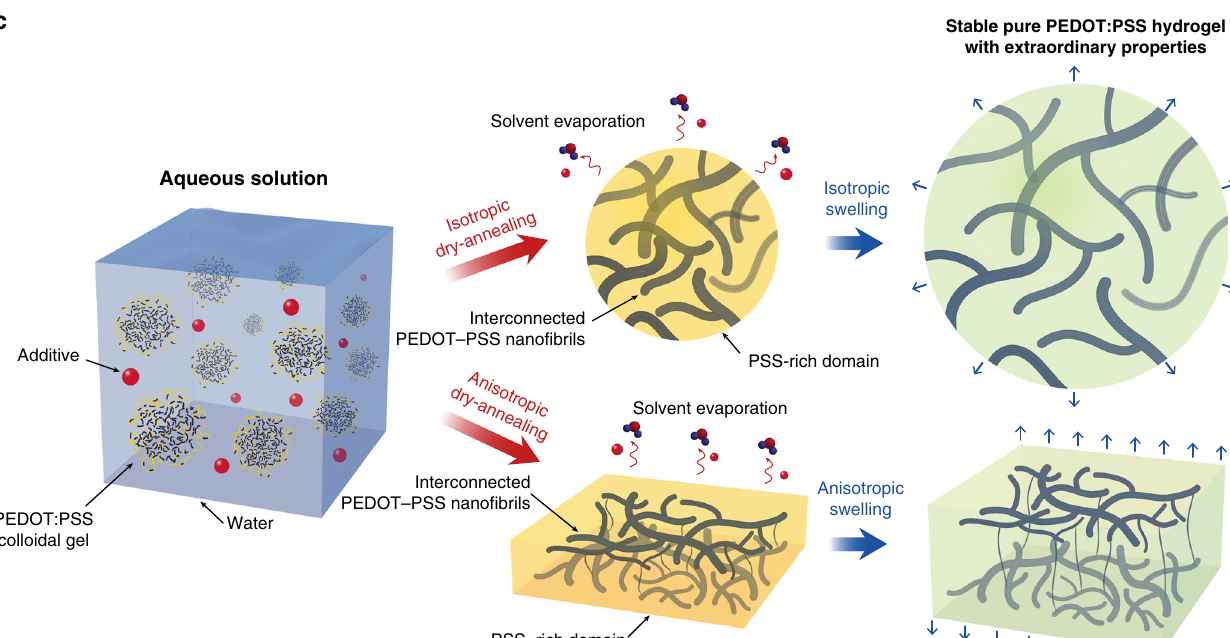
Fig. 1 Schematic illustration of pure PEDOT:PSS hydrogel preparation. a Chemical structures of PEDOT, PSS, and DMSO. b Typical drying and swelling processes of pristine PEDOT:PSS without DMSO. c Dry-annealing and swelling processes of PEDOT:PSS with DMSO as the additive. Isotropic dry- annealing of PEDOT:PSS aqueous solution with DMSO leads to isotropic swelling of the stable pure PEDOT:PSS hydrogel with extraordinary properties, while anisotropic dry-annealing provides anisotropic swelling in out-of-plane or thickness